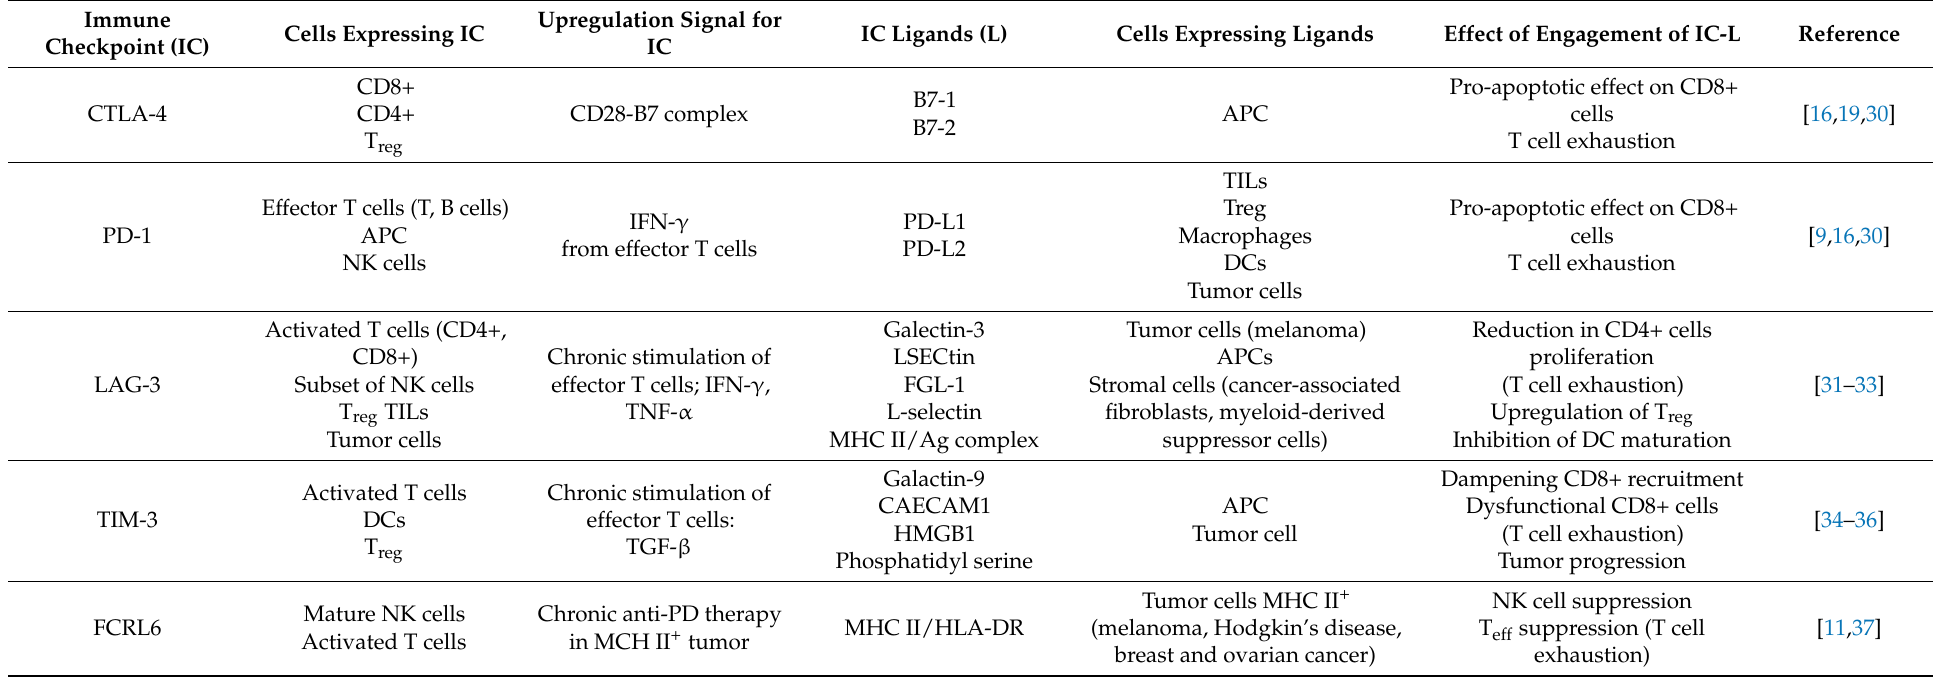
Table 1. Immune checkpoint proteins, their ligands and biological